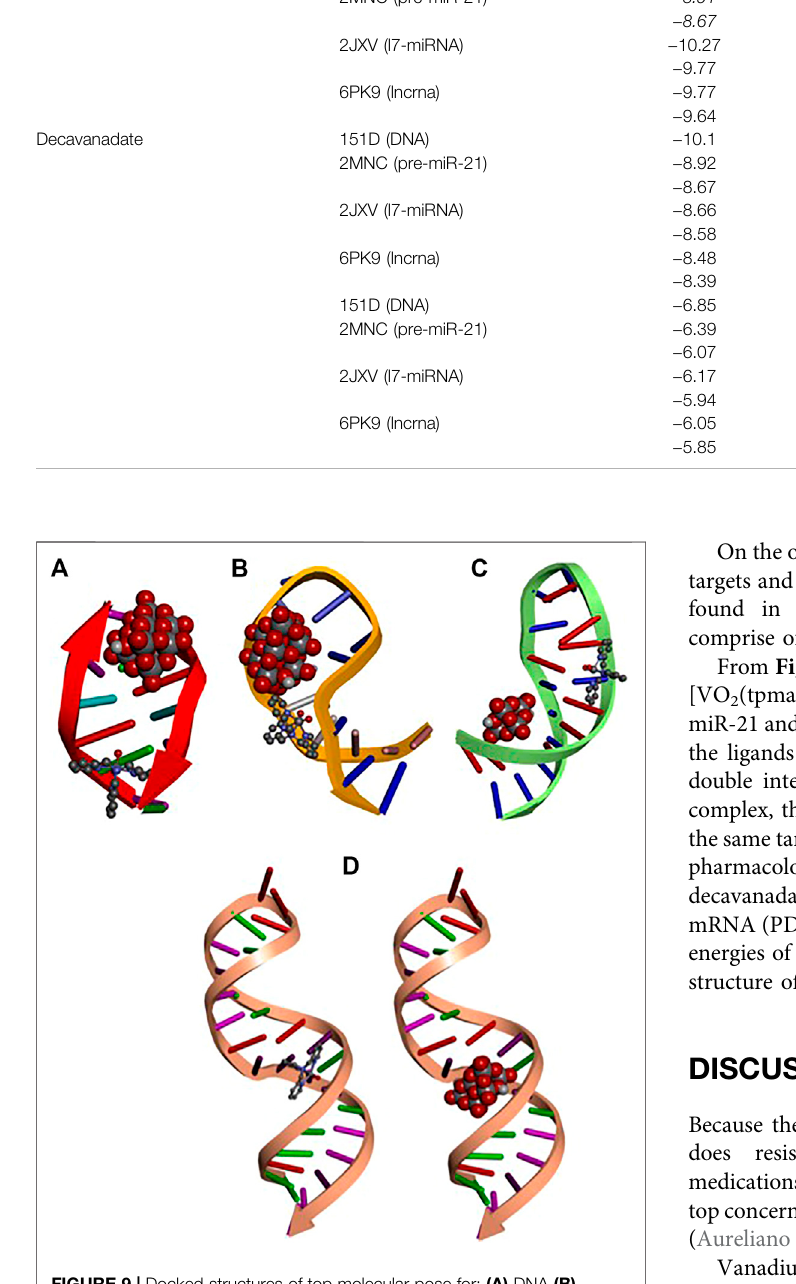
FIGURE 9 | Docked structures of top molecular pose for: (A) DNA (B) pre-miR-21 (C) l7-miRNA (D) lncRNAwithdiprotonateddecavanadateshown in CPK display style and [VO 2 (tpma)] + shown in scaled ball and stick style.